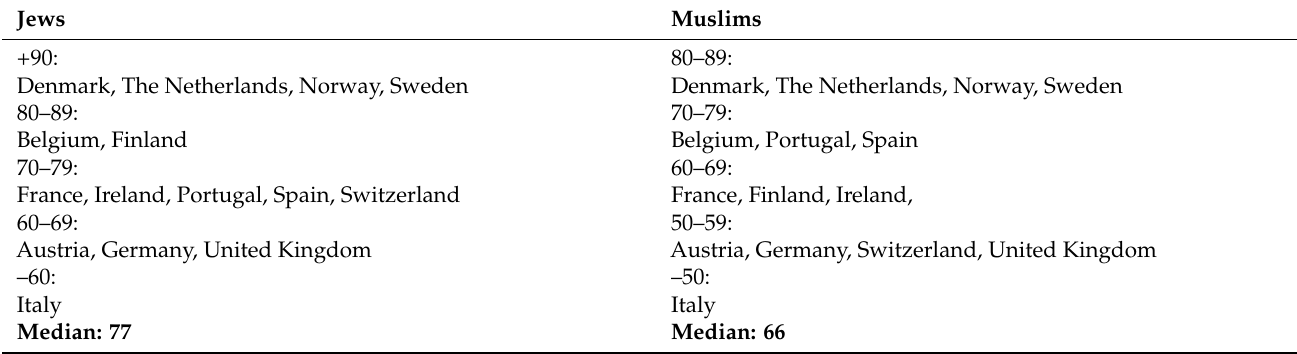
Table 1. Attitudes toward Jews and Muslims in Western Europe (acceptance of a Jew or a Muslim into the family in